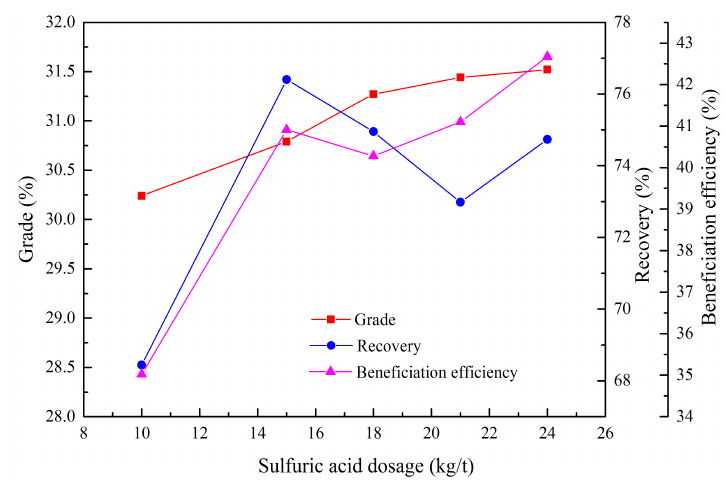
Figure 4. Effect of sulfuric acid dosage on the reverse flotation of the rougher concentrate.